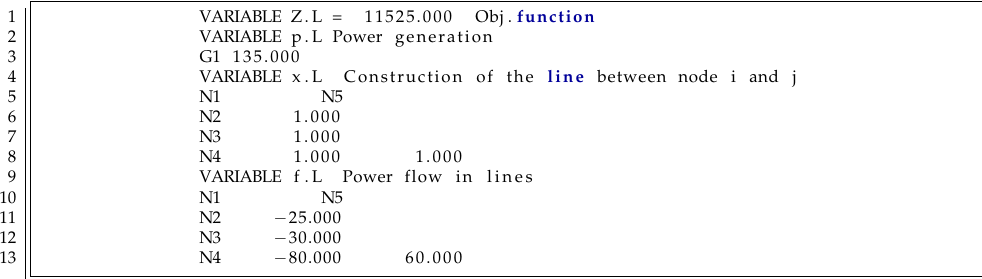
Figure 3. Solution of the MINLP model by GAMS.